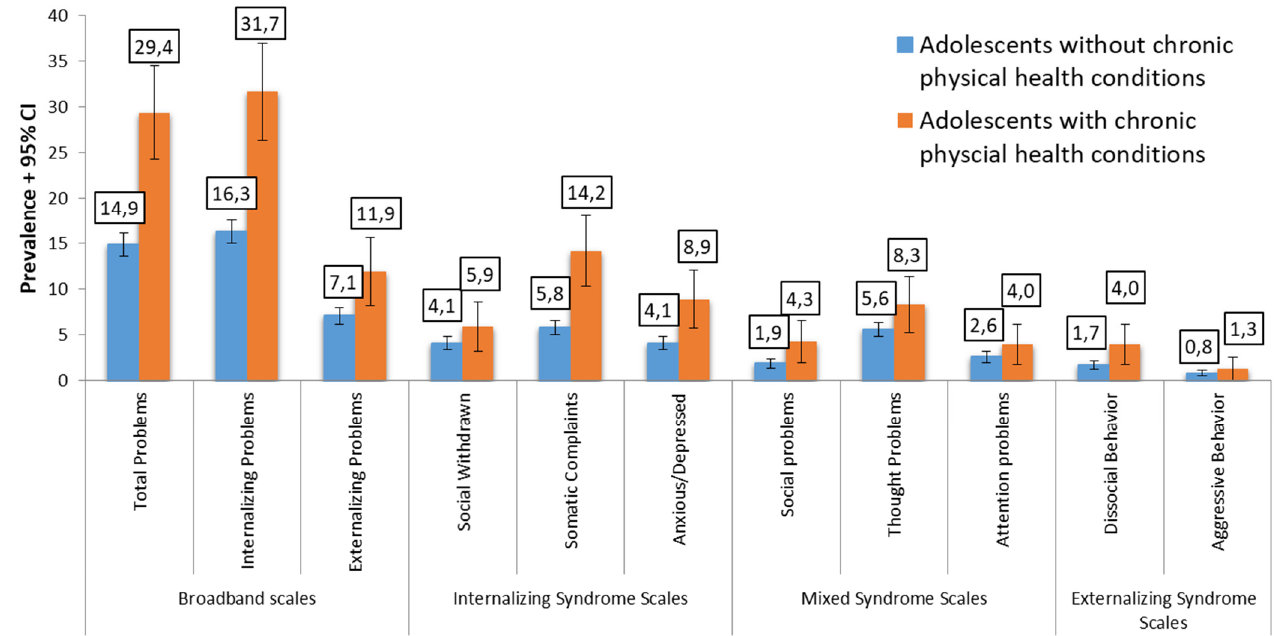
Figure 1. Prevalence (%) of clinically relevant mental health problems in adolescents with vs. with- out chronic physical health conditions. chronic physical health